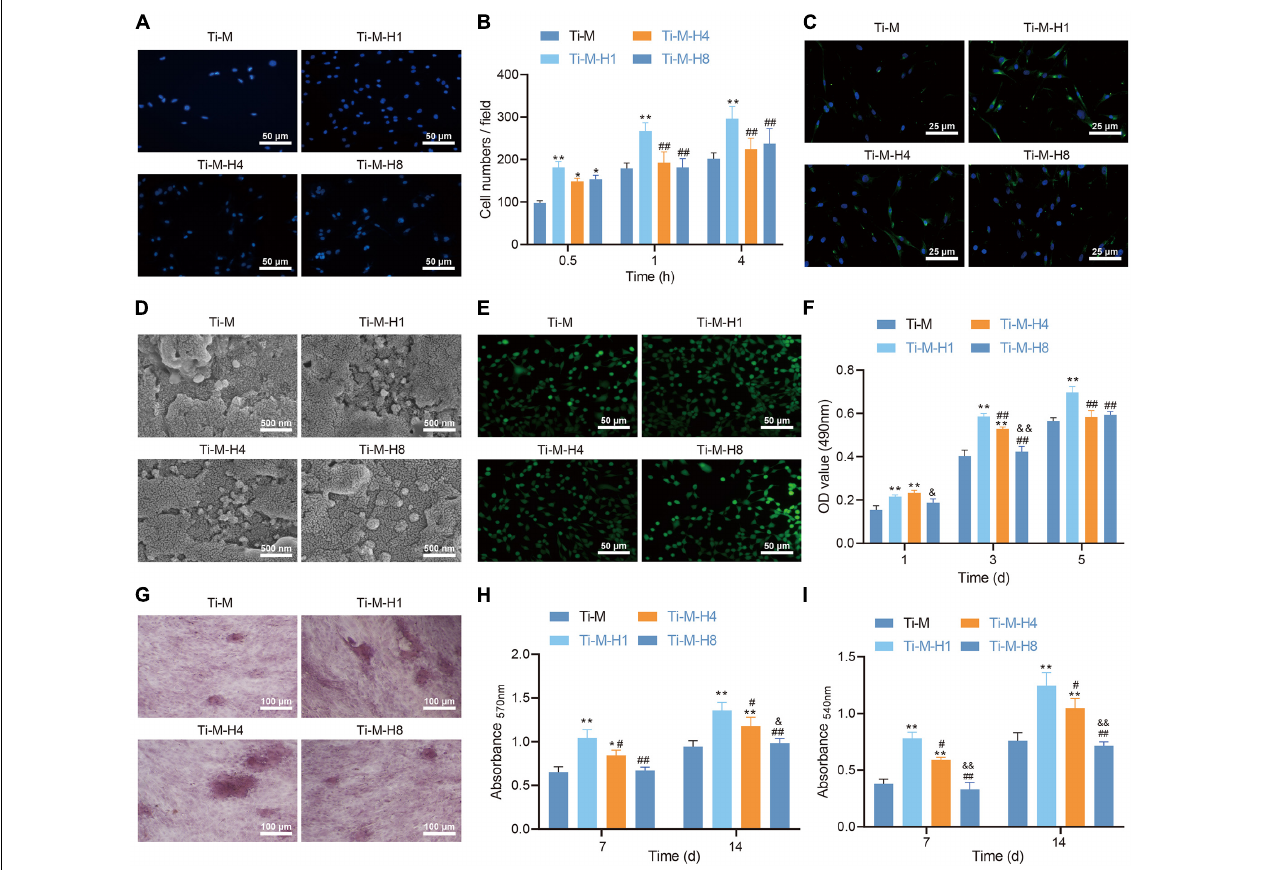
FIGURE 2 | Ti–M–H coating promotes osteogenesis in vitro . (A) Representative images of osteoblasts that adhered to the coating surface for 0.5 h by 4,6-diamidino-2-phenylindole. (B) Quantitative results of MC3T3-E1 cells that adhered to the coating surface for 0.5, 1, and 4 h. (C) Fluorescent images of cell skeleton of MC3T3-E1 cells after 24 h of incubation on the sample surface. (D) Scanning electron microscopy images of MC3T3-E1 cells cultured on the coating surface for 1 day. (E) Live/dead images of MC3T3-E1 cells cultured on the sample surface for 1, 3, and 5 days. (F) MC3T3-E1 cell proliferation on the coating surface as determined by the 3-(4,5-dimethylthiazol-2-yl)-2,5-diphenyltetrazolium bromide method. (G) ALP staining images of MC3T3-E1 cells cultured on the coating surface for 7 days. (H) Quantification of collagen secretion of MC3T3-E1 cells cultured on the coating surface for 7 and 14 days. (I) Quantification of extracellular matrix mineralization of MC3T3-E1 cell cultured on the coating surface for 7 and 14 days. * P < 0.05 compared with Ti–M. # P < 0.05 compared with Ti–M–H1. & P < 0.05 compared with Ti–M–H4. ** P < 0.01 compared with Ti–M. ## P < 0.01 compared with Ti–M–H1. && P < 0.01 compared with Ti–M–H4. The experiments were repeated three